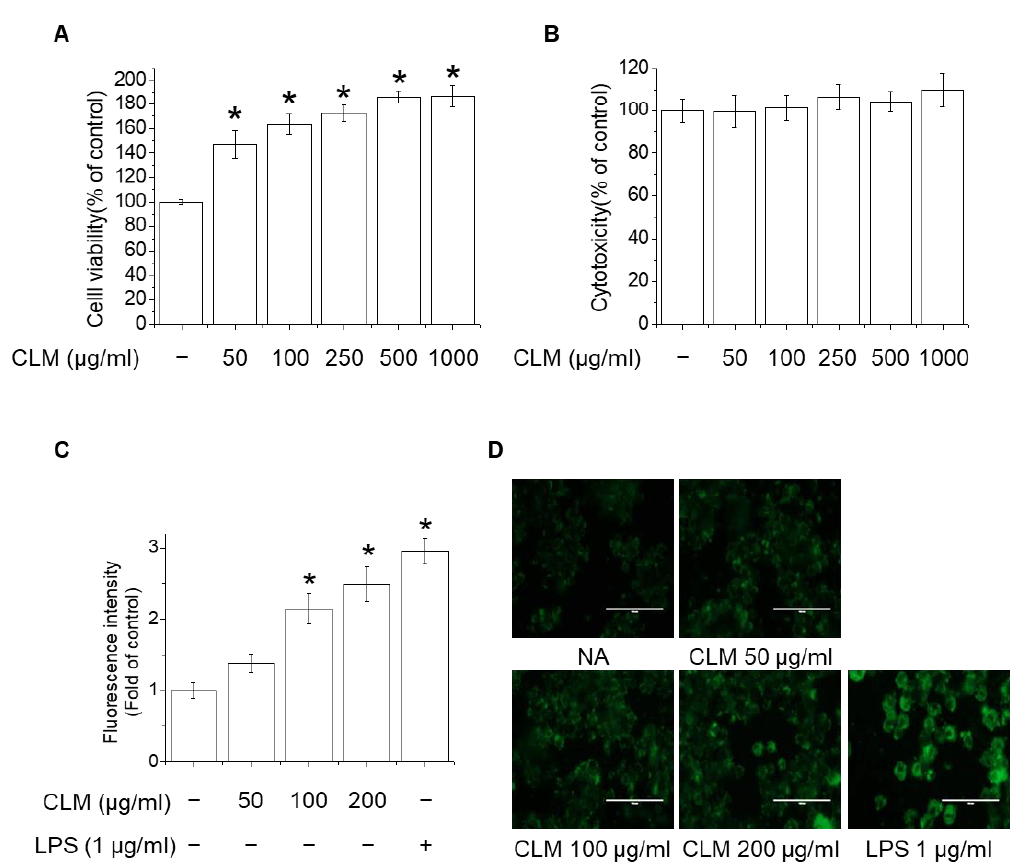
Figure 4. Effects of CLM on cell viability and phagocytic activity in macrophages. Cells were treated with various concentrations of CLM (50 – 1000 μ g/mL) for 24 h. ( A ) Cell viability was determined by MTT assay. ( B ) Cell cytotoxicity was determined by LDH release assay. ( C , D ) Cells were treated with various concentrations of CLM (50, 100, and 200 μ g/mL) for 24 h. After adding FITC-labeled E . coli , the cells were incubated for 2 h. ( C ) Cell culture medium containing unphagocytosed FITC-labeled E . coli was removed and fluorescence was measured with a microplate reader. ( D ) Fluorescence microscopy image of RAW264.7 cells stained with FITC-labeled E . coli for 2 h. All data are expressed as the mean ± SD of three independent experiments. * p < 0.01 vs. control group.